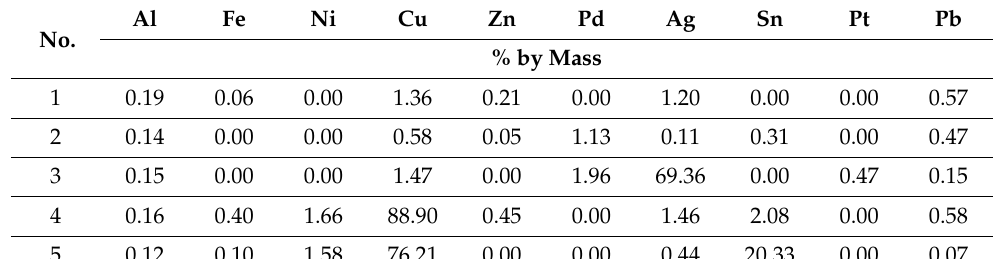
Table 11. Point chemical compositions of the lead ingots after melting with PCB pyrolyzate “server”,